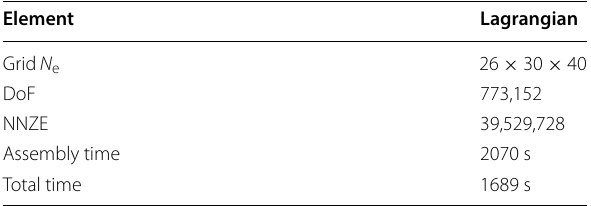
Table 4 Time and memory used in MoVFEM with the non‑ flat topography